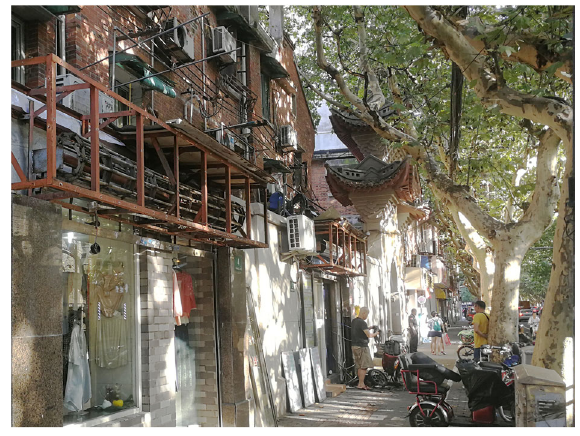
Fig. 9 The façade of Bugaoli facing the South Shaanxi